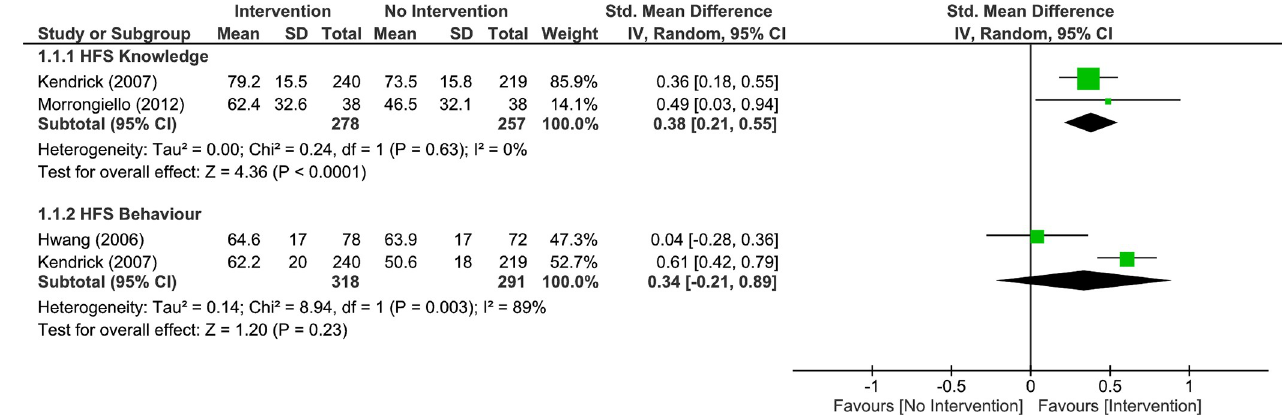
Fig 3. Analysis 1.1.1 forest plot of comparison: Intervention vs no intervention, up to 4 months–primary school children, outcome: Home fire safety knowledge, 2 RCTs. Analysis 1.1.2 Forest plot of comparison: Intervention vs No Intervention, up to 4 months–Primary School Children, outcome: Home Fire Safety Behaviour, 2 RCTs. Higher values indicate better/improved